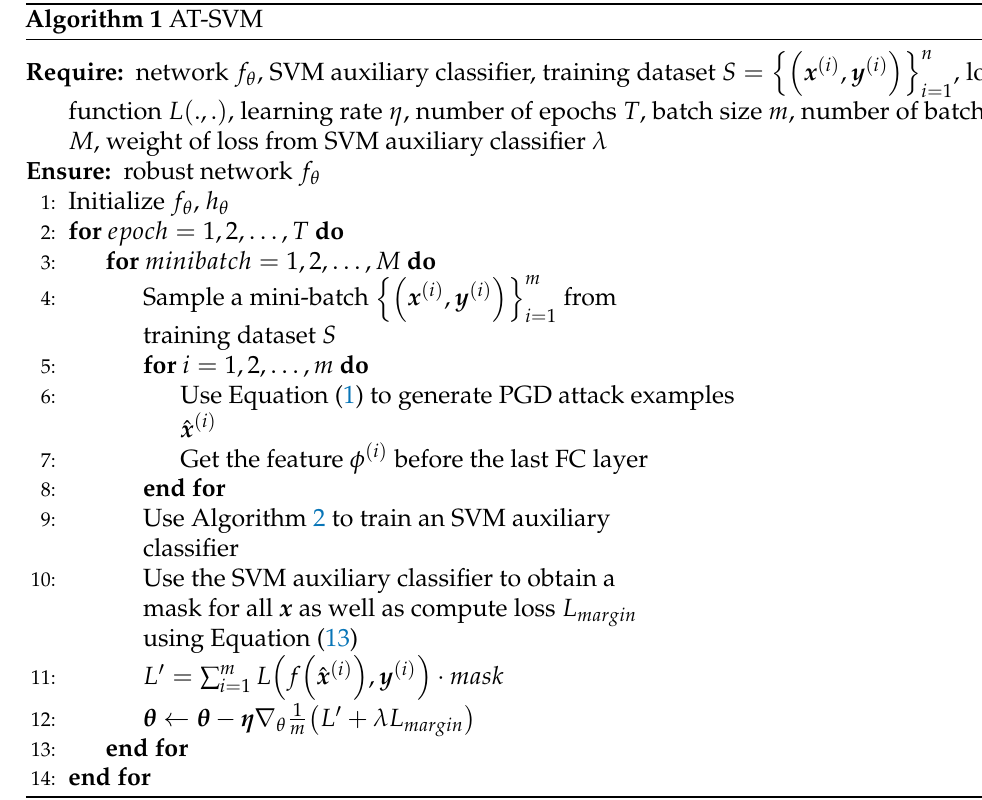
Algorithm 2 is an SVM auxiliary classifier, which is trained using both the adversarial data and the natural data and returns a mask for them at the same time. AT-SVM leverages Algorithm 2 for obtaining the mask for all examples. For each mini-batch, AT-SVM selects examples that will be misclassified by the SVM auxiliary classifier and then updates the model parameters by minimizing the sum of the selected examples’